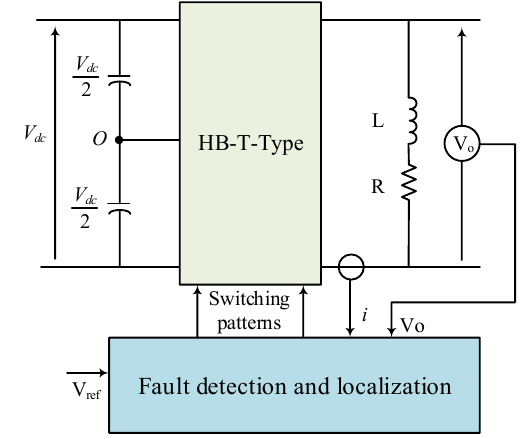
Fig. 6 HB-T-Type connected to a (R, L)